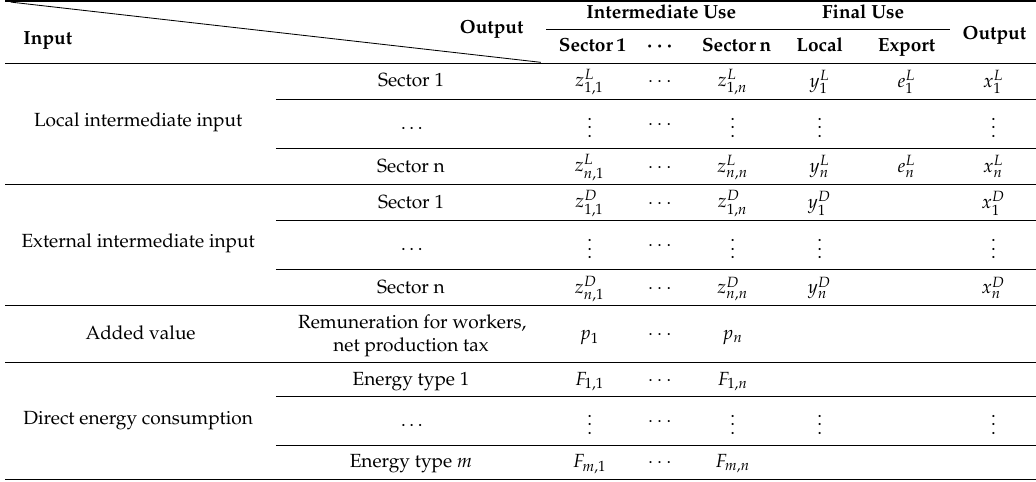
Table 1. Basic structure of the multi-scale ecological input–output